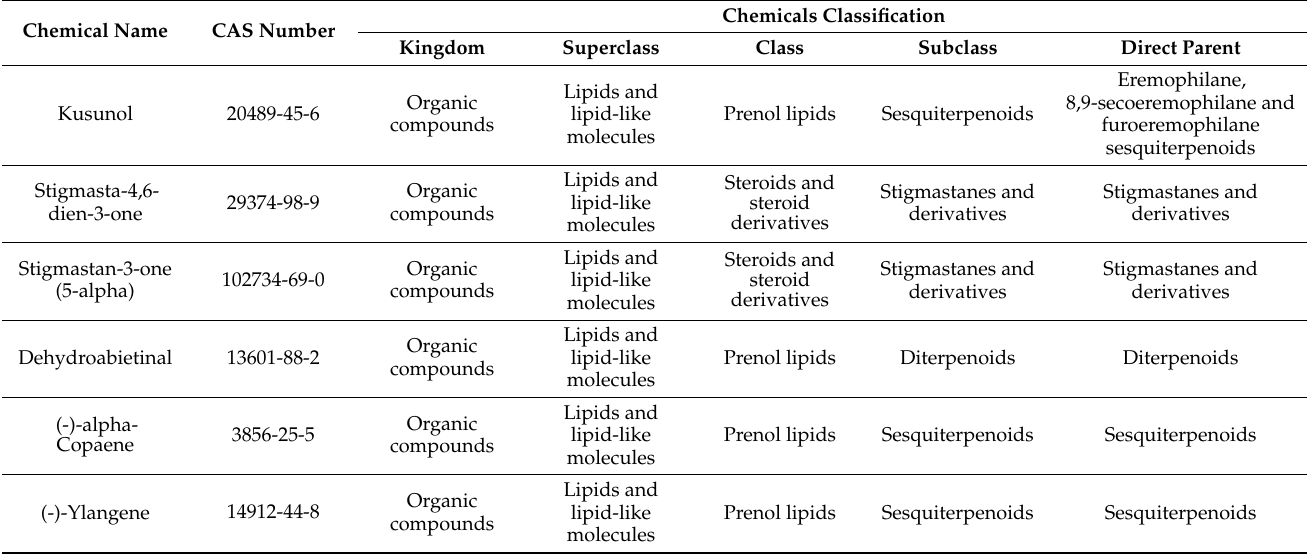
Table 2. List of chemicals simultaneously acting on three targets, S5R1, S5R2 and